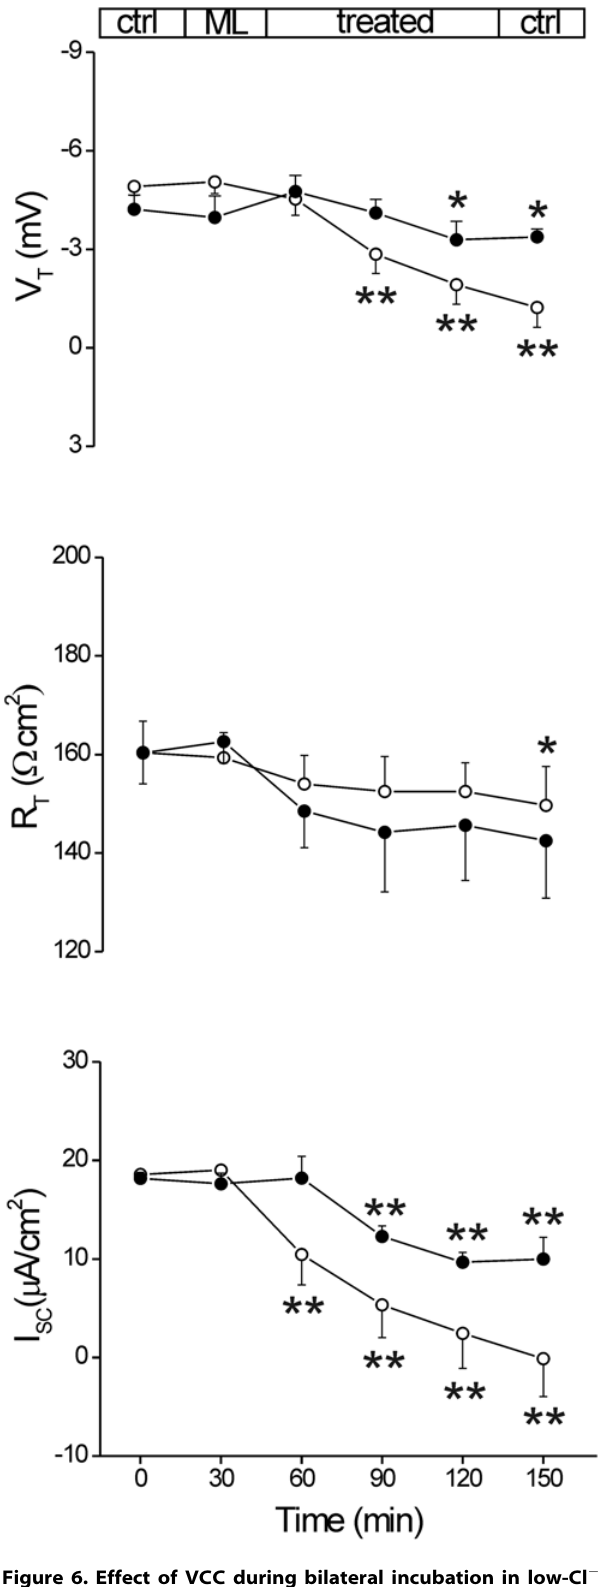
Figure 6. Effect of VCC during bilateral incubation in low-Cl 2 solution. The colon specimens mounted in Ussing chamber were incubated in low-Cl 2 (9 mM) solution, from the beginning to the end of the experiment, in the presence or in the absence of mucosal VCC 1 nM. Electrical parameters were measured as reported in legend of